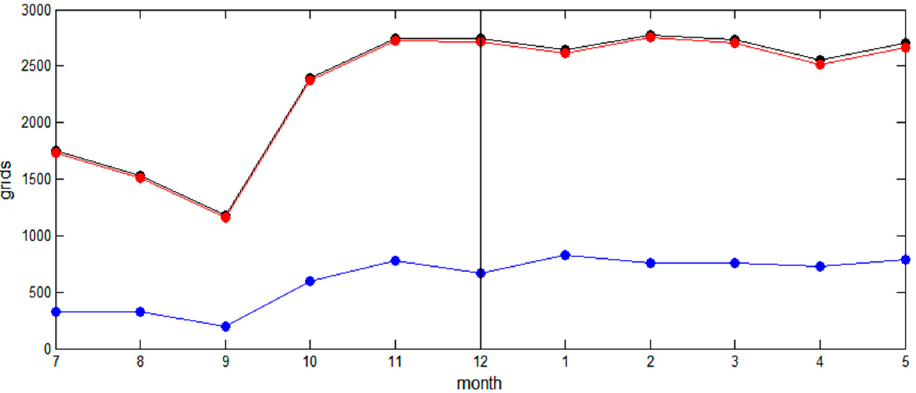
Figure 5. Summary of the number of grids: The color of the broken line in the figure indicates the same meaning as in the Figure 4.